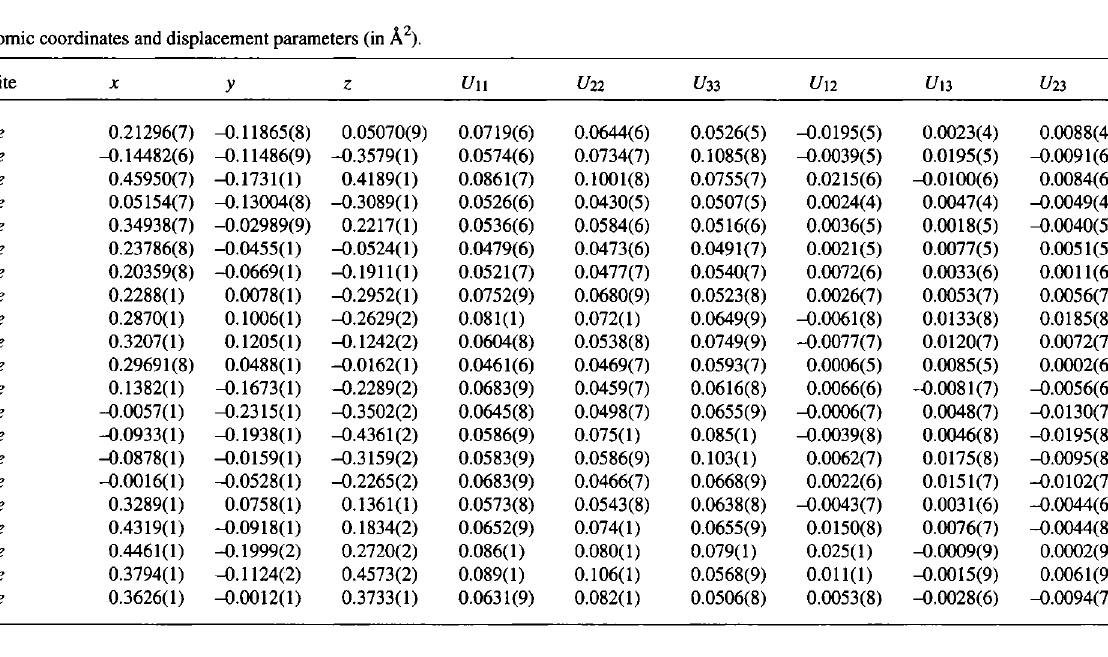
Table 3. Atomic coordinates and displacement parameters (in Ä 2